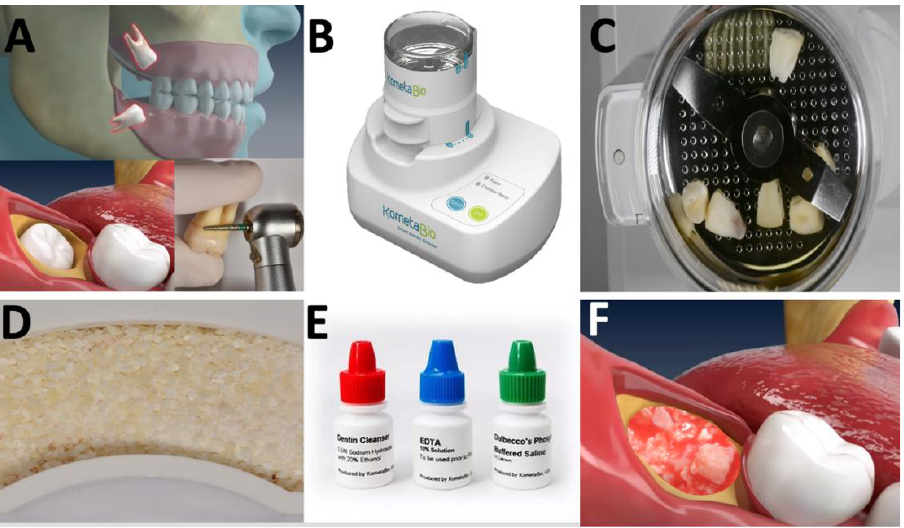
Figure 1. Schematics of the specimen preparation and clinical application: ( A ) Third molar extraction; ( B ) Smart Dentin Grinder TM apparatus (KometaBio Inc., Cresskill, NJ, USA); ( C ) specimens in a sterile trituration chamber; ( D ) dentin granules with size ranging from 300 to 1200 µm ; ( E ) cleaning and demineralizing solutions kit; ( F ) alveolar ridge preservation procedure.